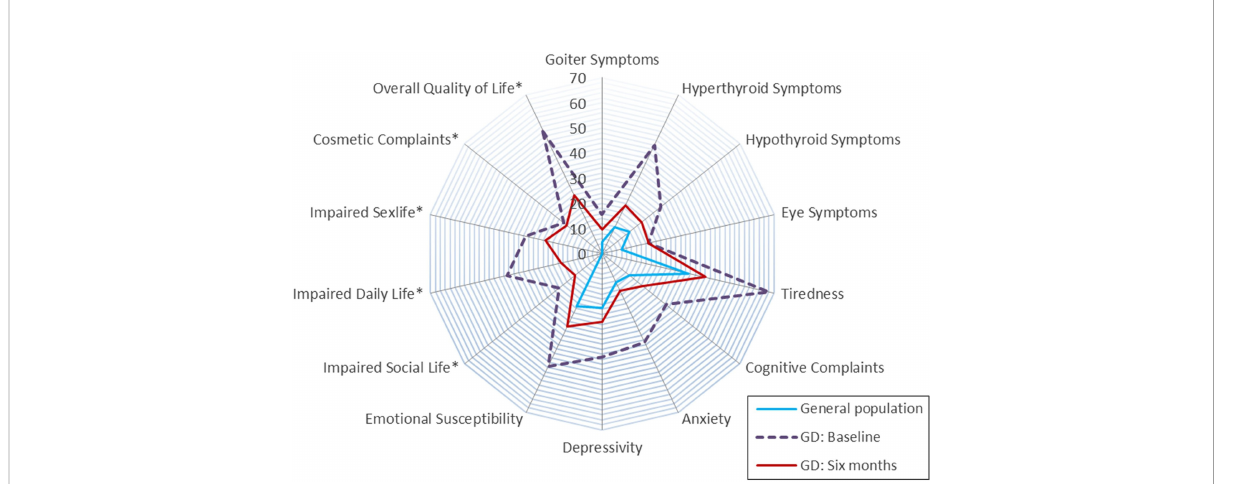
FIGURE 1 Radar plot showing ThyPRO scales scores for patients with Graves ’ disease at baseline (i.e. before initiation of treatment, N=88) and 6 months after treatment (N=66), as well as scores from a general reference population (N=739). The scales range from 0 to 100, with higher scores indicating worse health status. *Items in these scales are asked with attribution to thyroid disease and cannot be answered by respondents from the general population. A radar plot gives a comprehensive overview of all quality of life domains and a few assessments can be shown in one plot. However, this type of graph is not well suited for multiple longitudinal assessments. The radar plot is based on data from Cramon et al. (51). GD: Graves ’